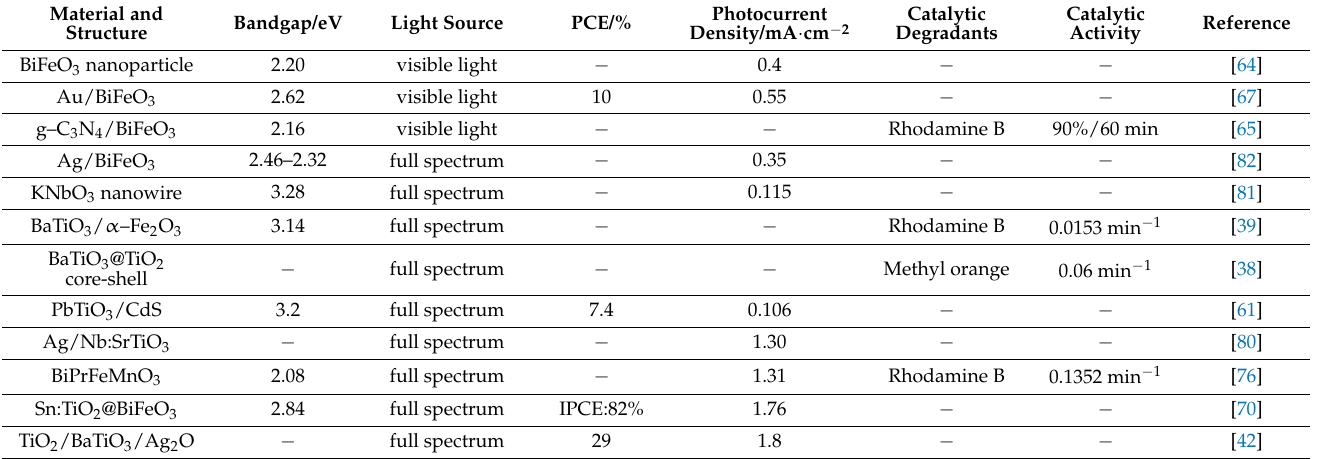
Table 1. Photocatalytic degradation and PEC performance using a variety of catalytic methods of ferroelectric material under one sun illumination